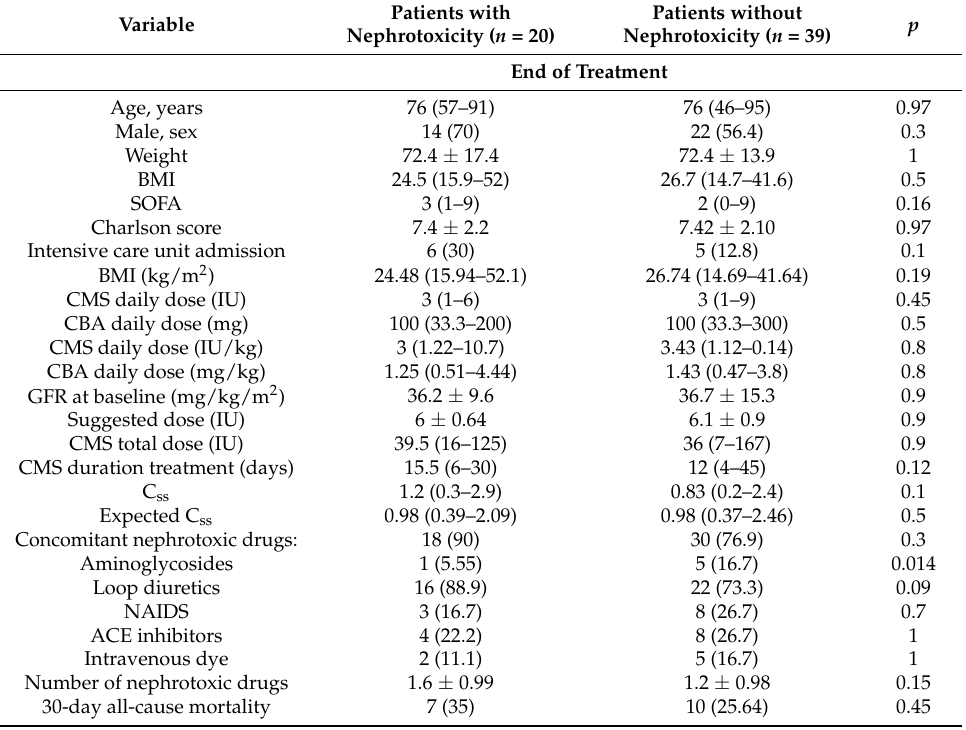
Table 4. Characteristics of patients with and without acute kidney injury at the end of